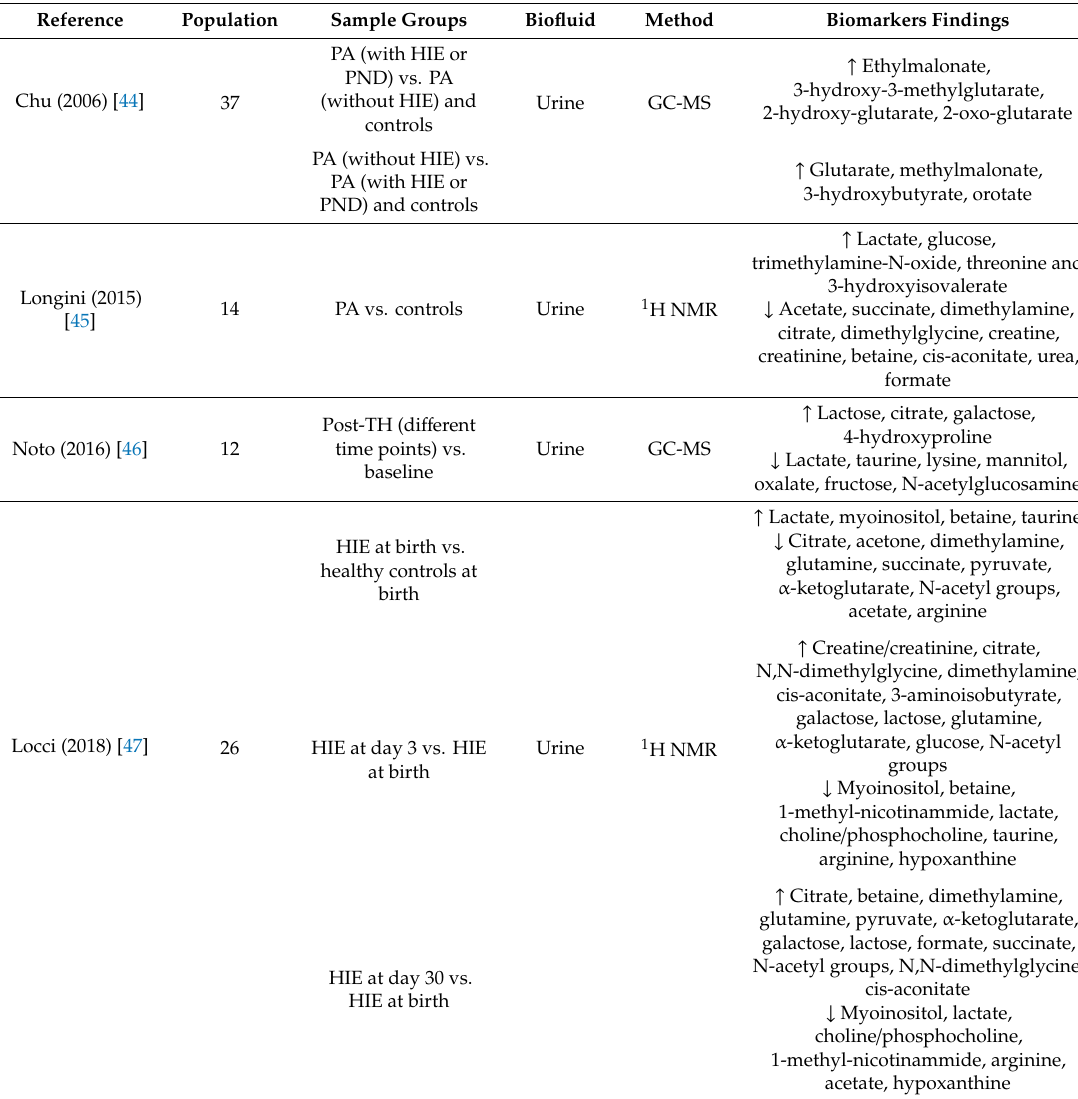
Table 2. Metabolomics studies performed on human